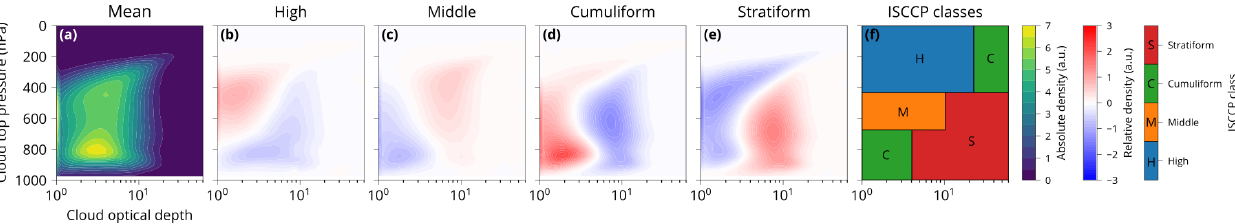
Figure 7. Histogram of cloud optical depth and cloud top pressure of the cloud types derived from CERES (2003–2020) by applying the ANN. (a) Mean of the four cloud types. (b–e) Difference from the mean for the classification of four cloud types. (f) ISCCP classification (Rossow and Schiffer,